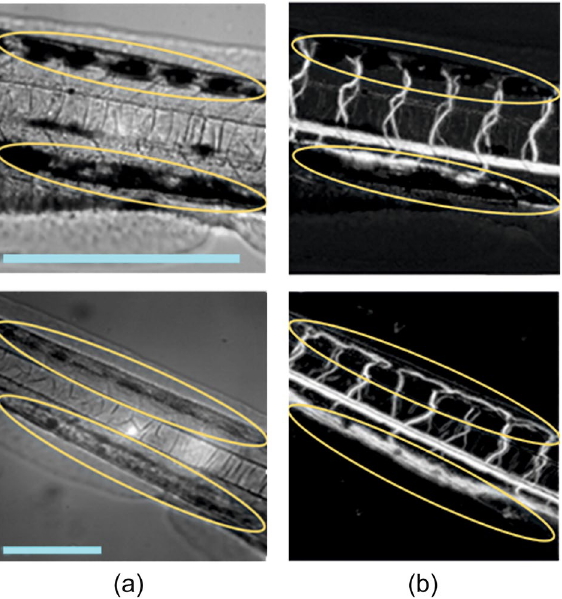
Figure 3. Example of acquired raw ( a ) and calculated vessel ( b ) images in VISNIR (upper row) and SWIR (lower row). Scale bar: 0.5 mm. Areas marked by yellow indicate the same parts of vena cardinalis and arteria segmentalis partly covered by pigment pattern.